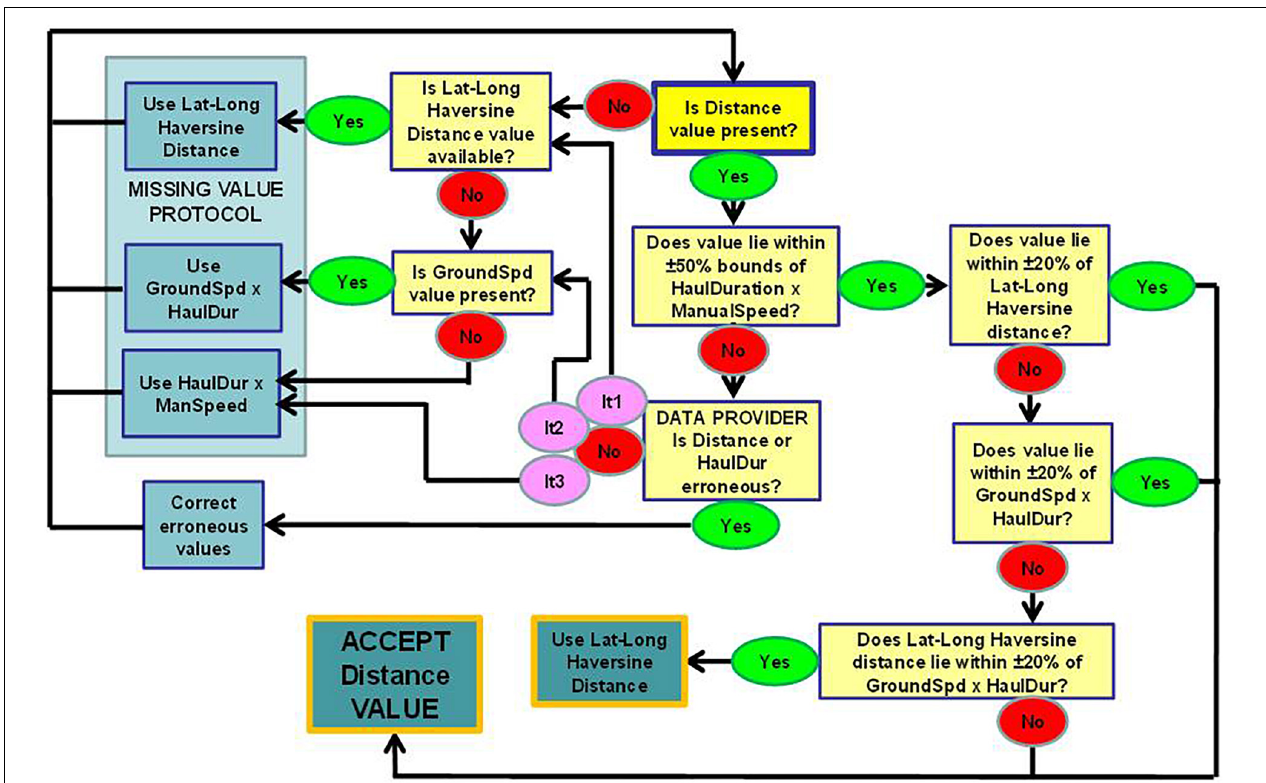
FIGURE 3 | Flow chart illustrating the steps involved in assessing the validity of recorded Towed distance values and to estimate missing and replace incorrect data form Moriarty et al. (2017). Source Code – GITHUB https://github.com/MarineScotlandScience/MSFD-QA-GFSM-A-DP/blob/master/6_Haul_QA (Line